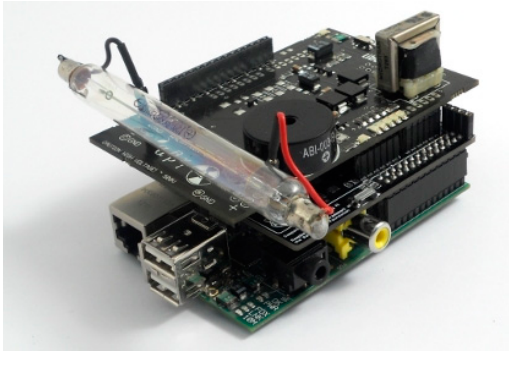
Figure 4. End device.